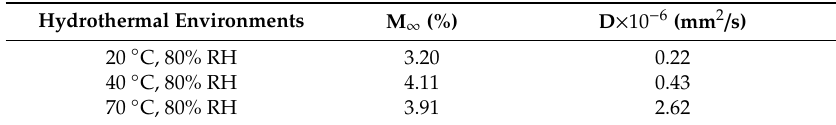
Figure 5. Water absorption process of nano ‐ clay grafted FFRPs at 20 ℃ , 40 ℃ and 70 °C under 80% RH. Table 3. Maximum water uptake and di ff usion coe ffi cient (D) of nano-clay grafted FFRPs at 20, 40 and 70 ◦ C under 80% Table 3. Maximum water uptake and diffusion coefficient (D) of nano ‐ clay grafted FFRPs at 20, 40 and 70 °C under 80% RH.